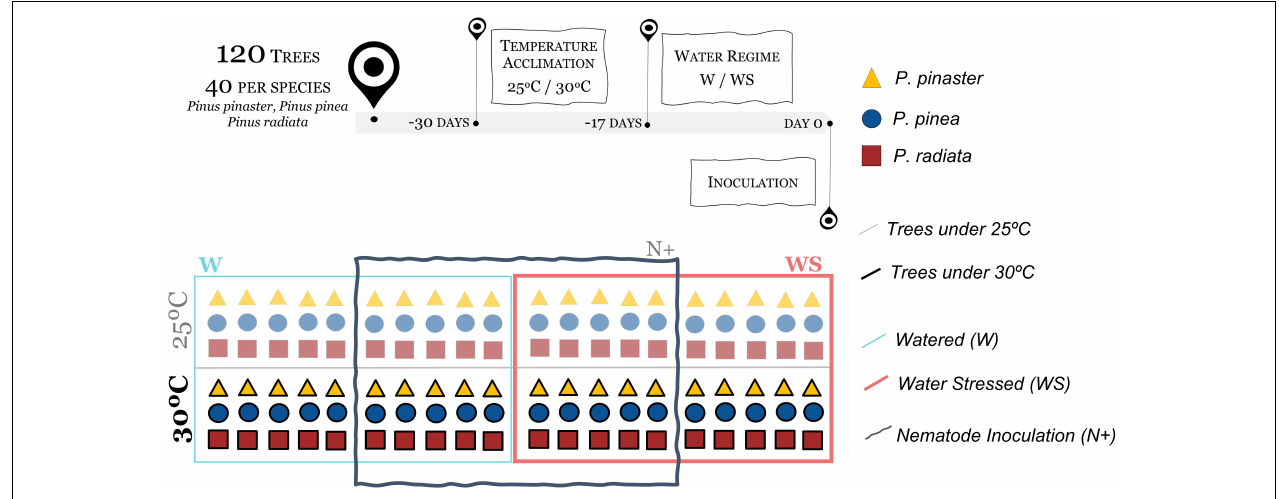
FIGURE 1 | Conceptual diagram of the experimental setup. The upper panel represents the initial process, highlighting the treatments [temperature (25/30 ◦ C); water regimes (W – watered/WS – water stressed); Bursaphelenchus xylophilus inoculation (N– non-inoculated/N+ inoculated)] applied to the three Pinus species ( P. pinaster, P. pinea, and P. radiata ). The lower panel shows the eight treatments applied to a total of 120 trees, 40/ Pinus species, five trees of each species/treatment (W25N–; W30N–; W25N+; W30N+; WS25N–; WS30N–; WS25N+;